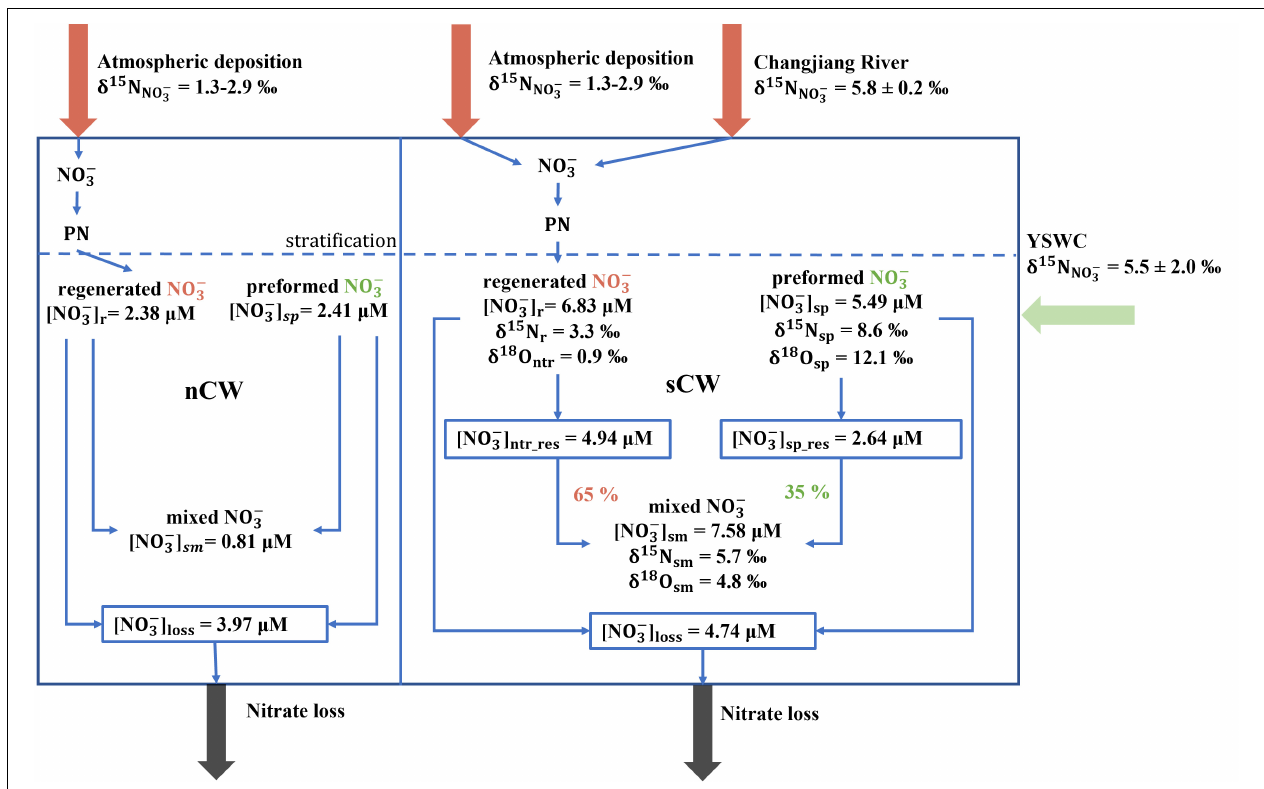
FIGURE 8 | Different nitrate budgets in the nCW and sCW. In both water masses, nitrate consists of the preformed nitrate and regenerated nitrate. The sCW is impacted by the inflow of Yellow Sea Warm Current (YSWC) in spring, the input from atmospheric deposition and inflow of the Changjiang River in summer, while nitrate is lost mainly to benthic denitrification. The nCW is impacted by the input of nitrate by atmospheric deposition only and nitrate loss mainly to benthic denitrification, the prevalence of which makes the area filled by nCW a net sink for nitrate in summer. Proportions for regenerated and preformed nitrate are estimated by the isotopic mixing only for the sCW because of a lack of isotope values in the nCW. [NO − 3 ], δ 15 N and δ 18 O are labeled by different subscript, “sp,” “sm” denotes the corresponding average values observed in spring and summer, respectively, “r/ntr” and “loss” denotes regeneration and loss, respectively, “ntr_res” and “sp_res” denotes the residual portion of the preformed nitrate in spring and of the residual portion of regenerated nitrate in summer, respectively.